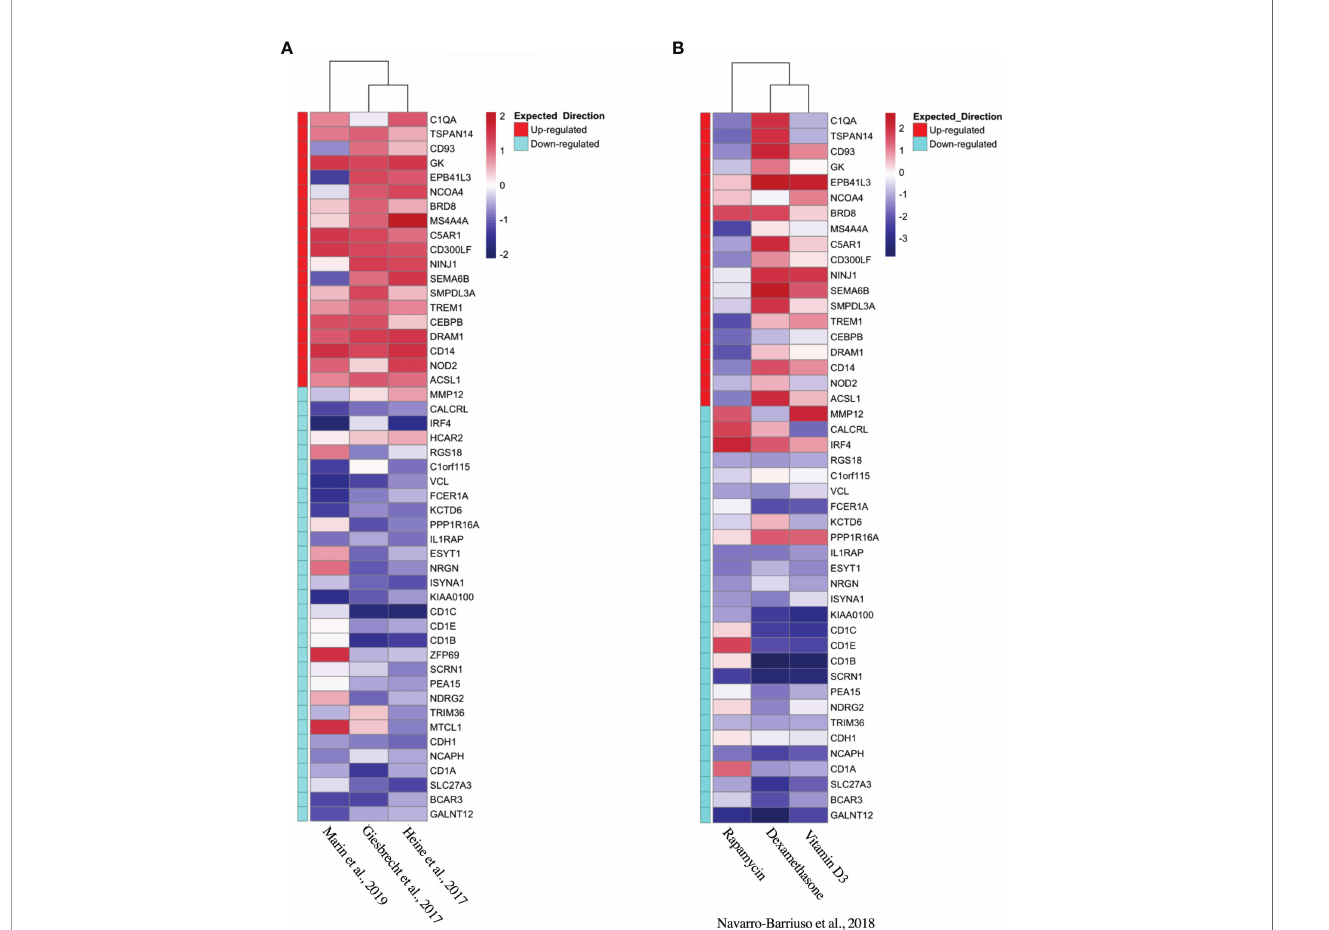
FIGURE 3 | Validation of tolDC transcriptome. Heatmap representation of upregulated and downregulated genes from the tolDC discovery gene set compared to expression in (A) GEO-derived or (B) ArrayDatabase validation gene